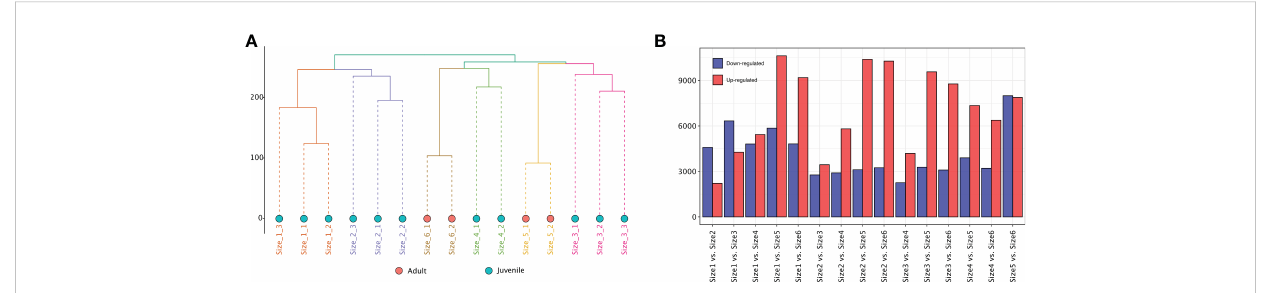
FIGURE 5 Transcriptome analysis of rhizomes from P. sibiricum at different growth stages. (A) Hierarchical clustering of different rhizomes using the FPKM values of the transcriptome pro fi les. The dots in salmon represent adult rhizomes. The dots in turquoise represent juvenile rhizomes. (B) The number of up- and down-regulated differentially expressed transcripts (DETs) in the different combinations for